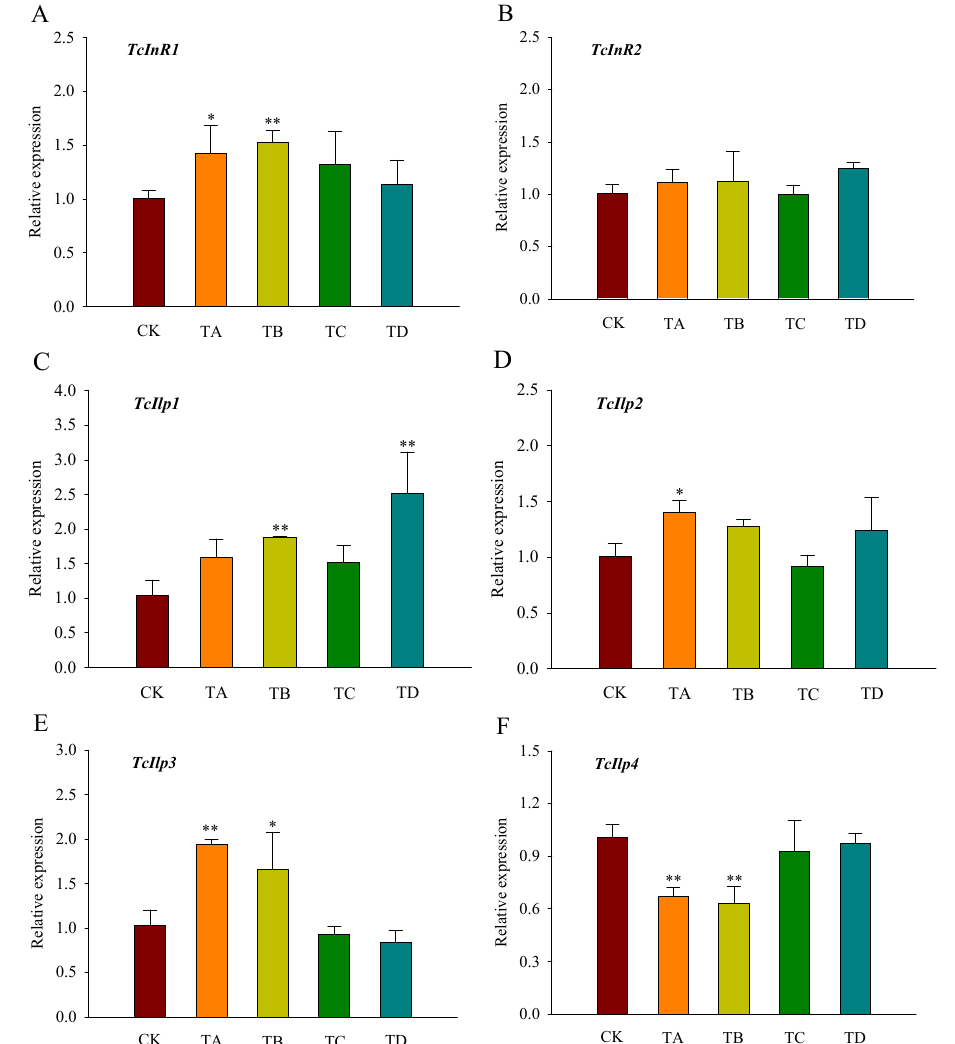
Figure 6. Relative expression levels of genes related to the insulin signaling pathway (( A ) TcInR1 ; ( B ) TcInR2 ; ( C ) TcIlp1 ; ( D ) TcIlp2 ; ( E ) TcIlp3 ; ( F ) TcIlp4 ) in T. castaneum after 48 h of treatment with different concentrations of carbon dioxide, represented by CK, TA, TB, TC, and TD. CK, treated with air for 48 h; TA, treated with 25% CO 2 + 75% air for 48 h; TB, treated with 50% CO 2 + 50% air for 48 h; TC, treated with 75% CO 2 + 25% air for 48 h; TD, treated with 95% CO 2 + 5% air for 48 h. InR , insulin ‐ like reporter gene, included InR1 and InR2 ; Ilp , insulin ‐ like gene, including Ilp1 , Ilp2 , Ilp3 , and Ilp4 . * p < 0.05, ** p < 0.01, according to Student’s t ‐ test.